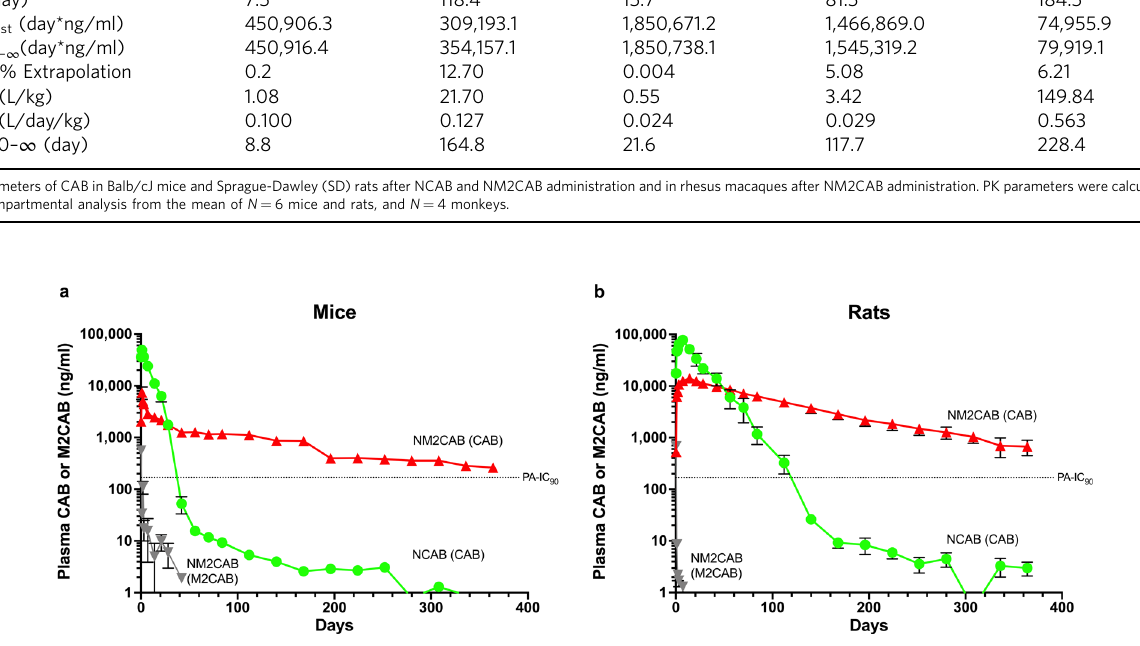
Fig. 1 Plasma concentration vs. time pro fi les of CAB and M2CAB plasma concentrations in mice and rats over one year. Plasma concentration over time was recorded for CAB and M2CAB over one year after a single IM injection (45 mg CAB equivalent/kg) of NCAB or NM2CAB in male Balb/cJ mice ( a ) and male SD rats ( b ). The dotted line indicates the CAB protein-adjusted IC 90 (PA-IC 90 ). For the NM2CAB treatment both the prodrug (M2CAB) and parent (CAB) were measured. Data are expressed as mean ± SEM ( N = 6 animals per group per time point).